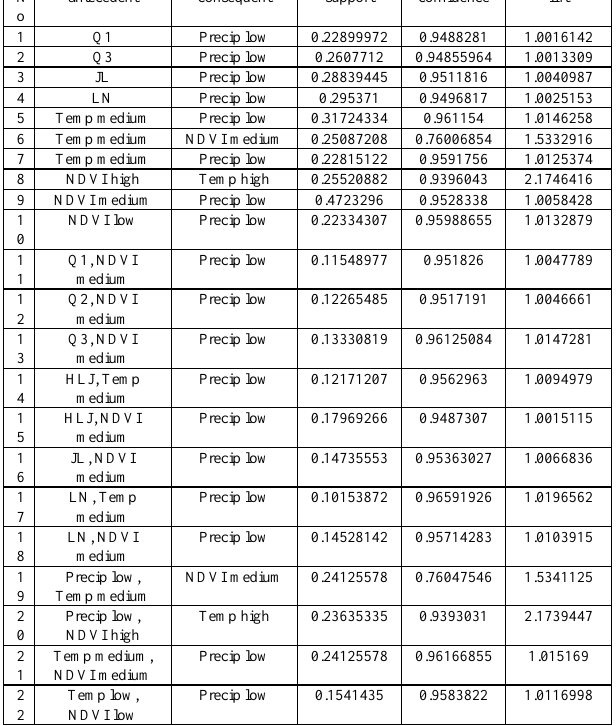
Figure 2.The distribution of novelty